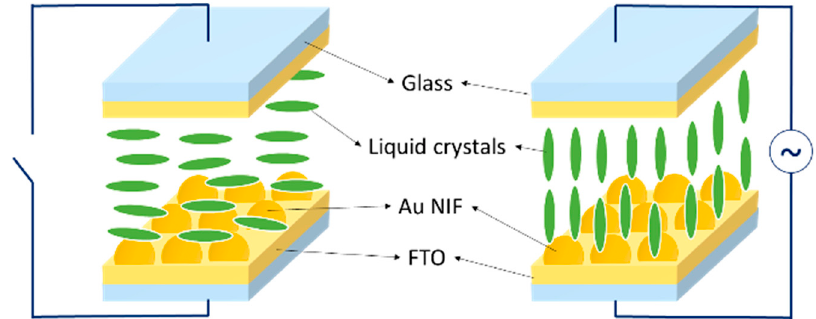
Figure 2. Schematic of the liquid crystal (LC)/gold nanoisland film (Au NIF) devices. An applied electric field across the cell causes the LC to reorient and changes the wavelengths of the resonant light.